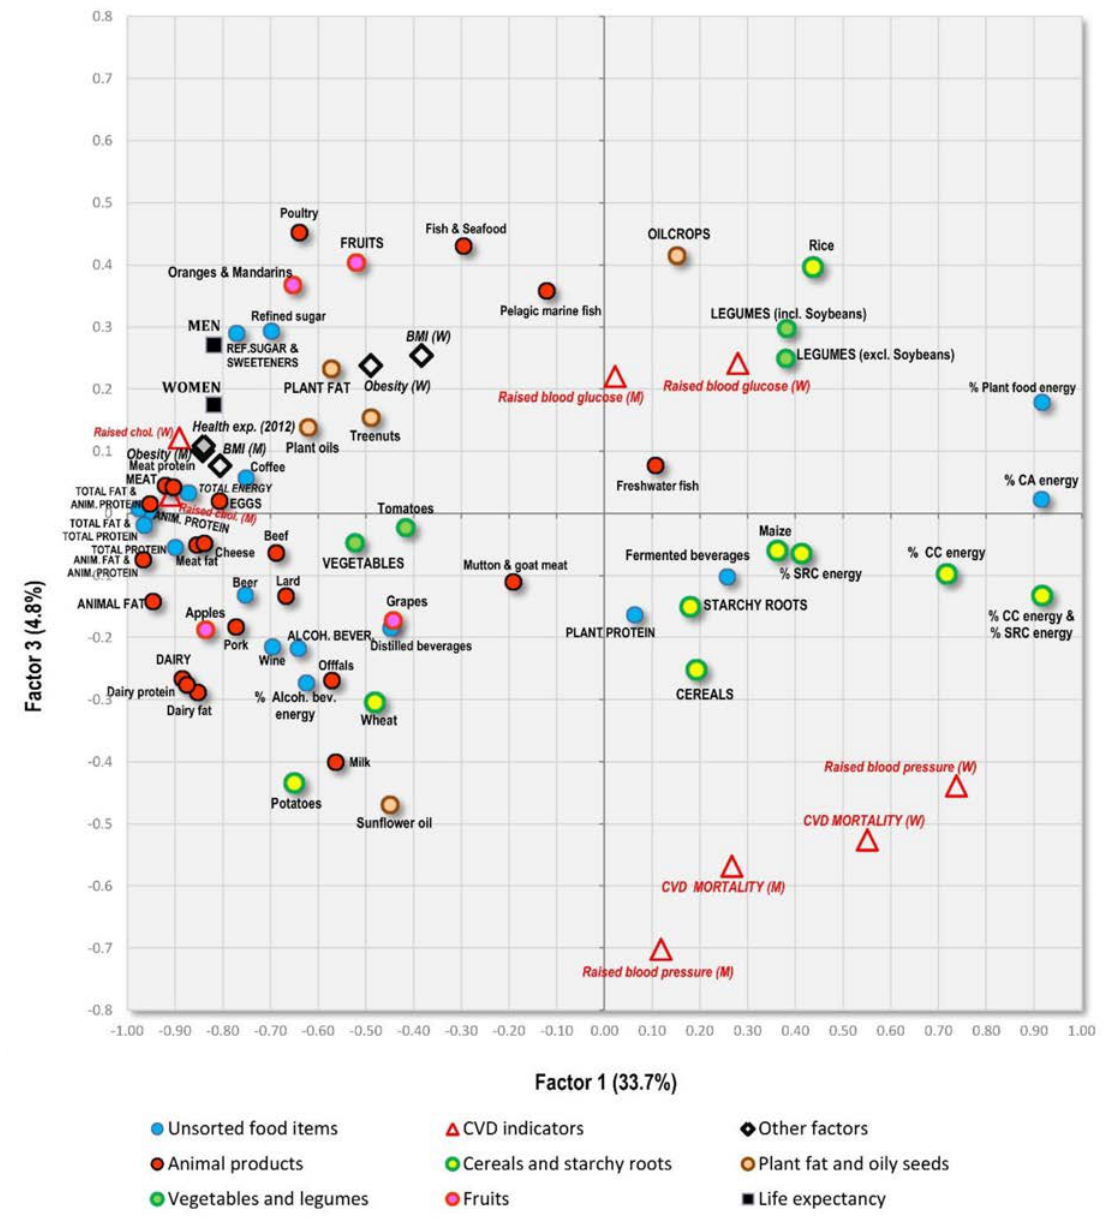
Figure 10. Factor analysis including 75 variables in 158 countries (Factor 1 vs. Factor 3) explaining 38.5% variability; Abbreviations: % CC energy = the mean proportion of carbohydrate energy from cereals; % SRC energy = the mean proportion of carbohydrate energy from starchy roots; % CA energy = the mean proportion of energy from carbohydrates and